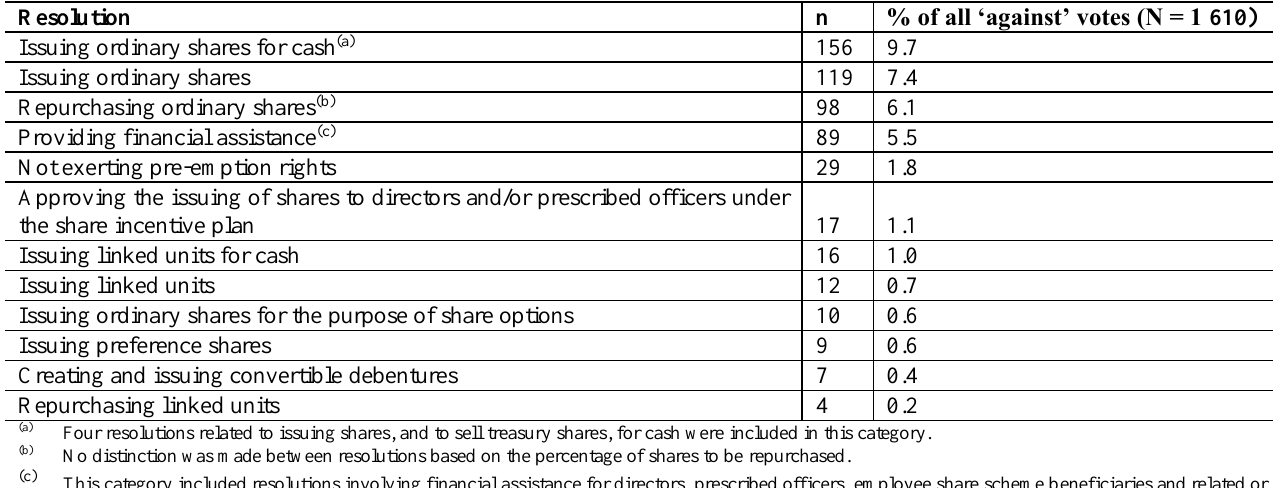
Table 5: Financially-oriented resolutions attracting ‘against’ votes